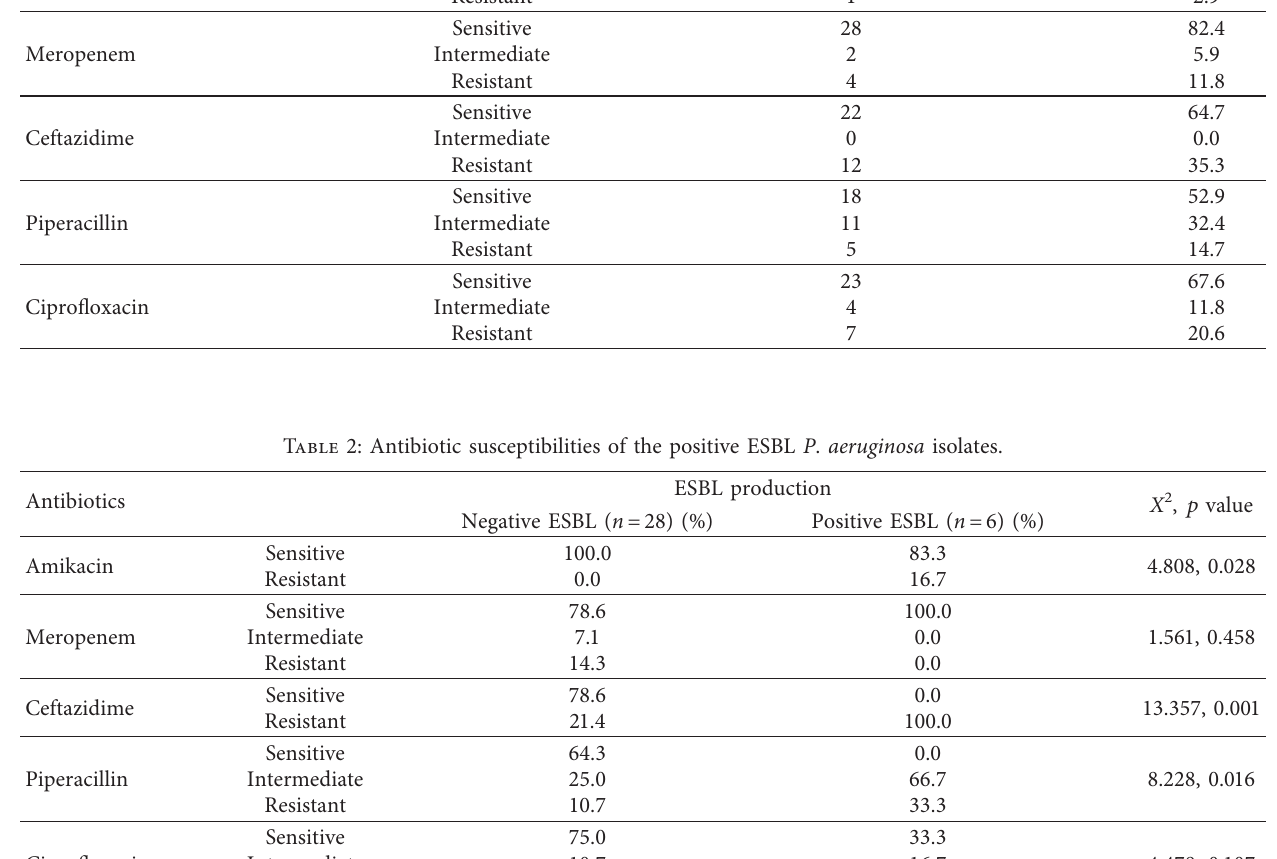
Table 1: Antibiotic susceptibilities of P. aeruginosa isolated at two hospitals in Khartoum. Antibiotics No.